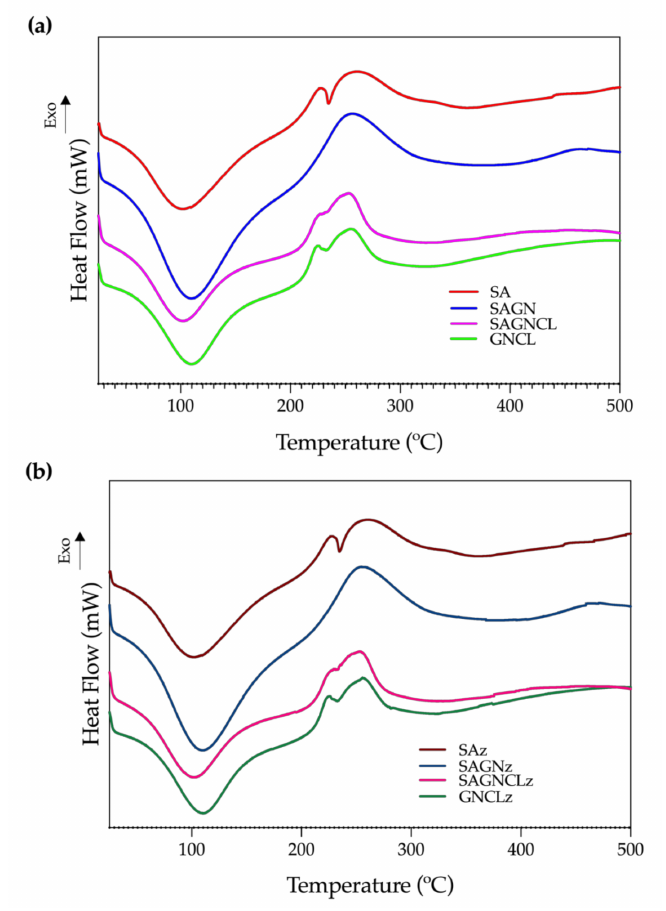
Figure 5. Differential Scanning Calorimetry (DSC) thermograms of the ( a ) SA, SAGN, SAGNCL, GNCL and ( b ) SAz, SAGNz, SAGNCLz and GNCLz microfibers in a temperature range of 25 to 500 ◦ C, performed at a heating rate of 10 ◦ C/min in a nitrogen atmosphere (200